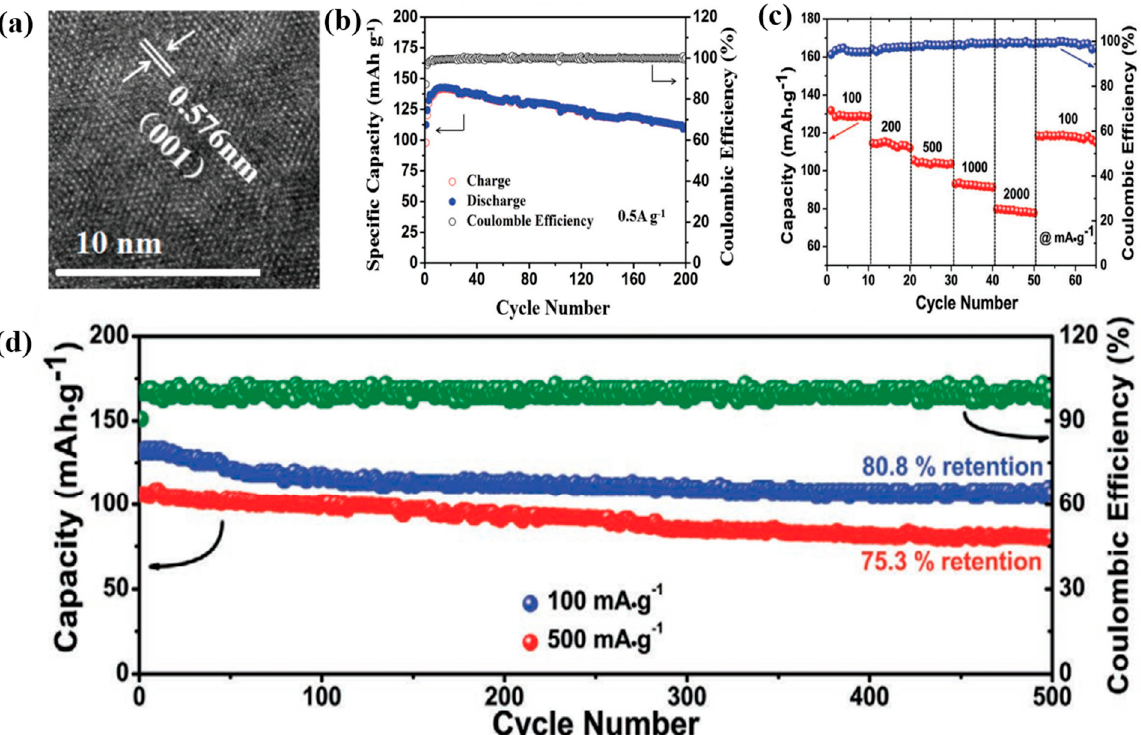
Figure 7. ( a ) TEM image of VS 2 nanosheets, ( b ) cyclic performance of VS 2 nanosheets at 500 mA g − 1 . Reprinted with permission from He et al. [81] Copyright 2017,WILEY-VCH Verlag GmbH and Co. KGaA, Weinheim. ( c ) Rate capability of VS 4 , ( d ) cyclic performance of VSe 2 nanosheets at 100 and 500 mA g − 1 . Reprinted with permission from Wu et al. [83] Copyright 2020, Wiley-VCH GmbH.